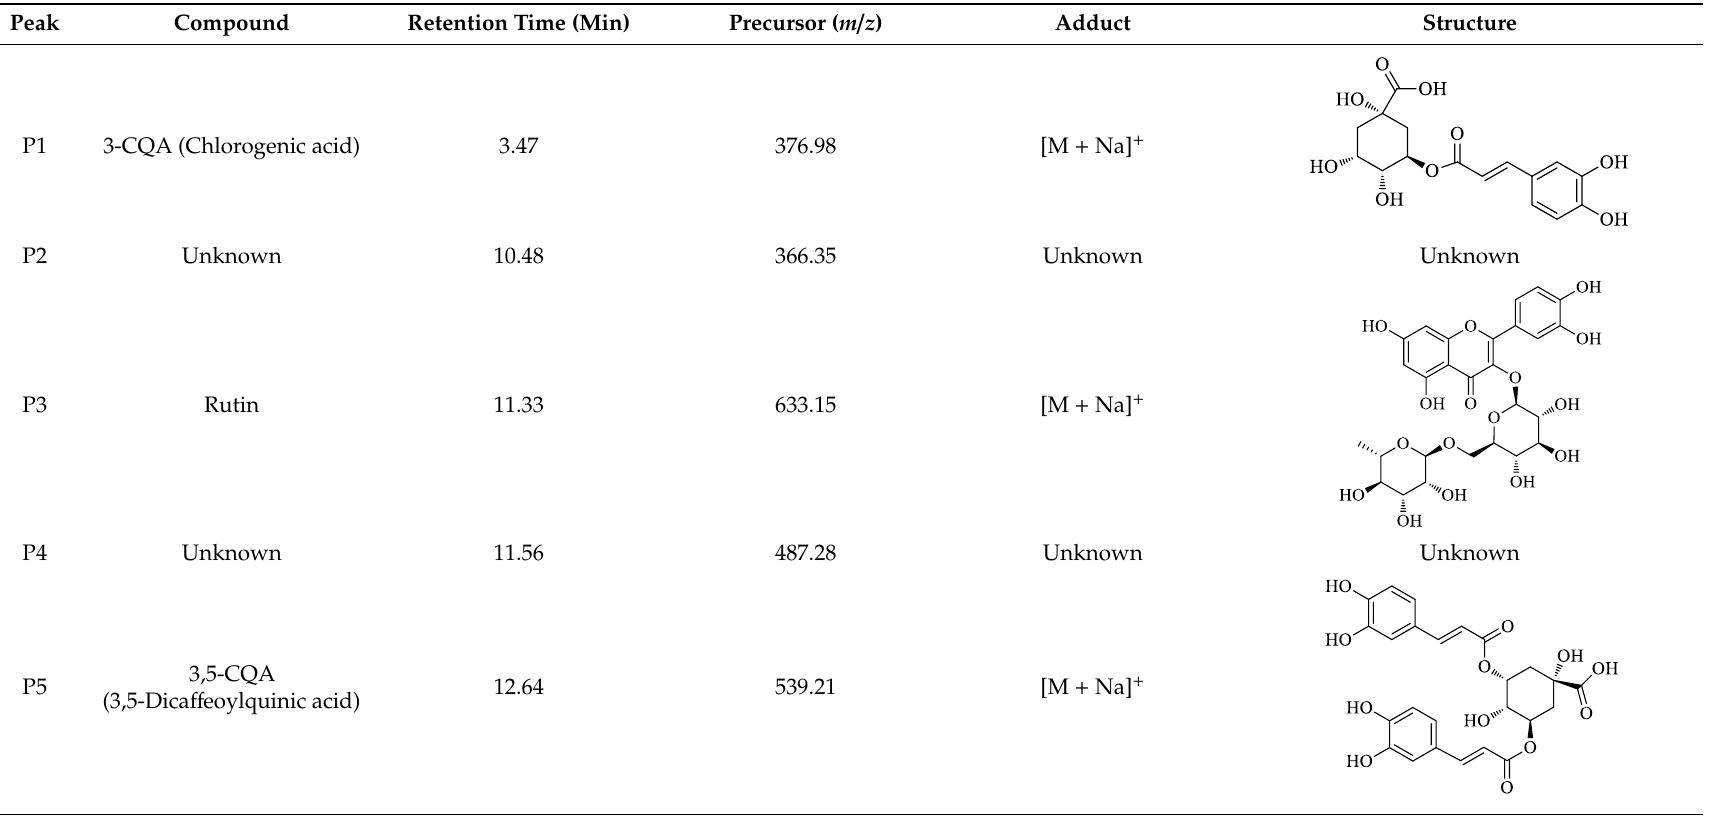
Table 1. Compounds, retention times, Precursor ( m / z ), and chemical structures of the constituents studied.